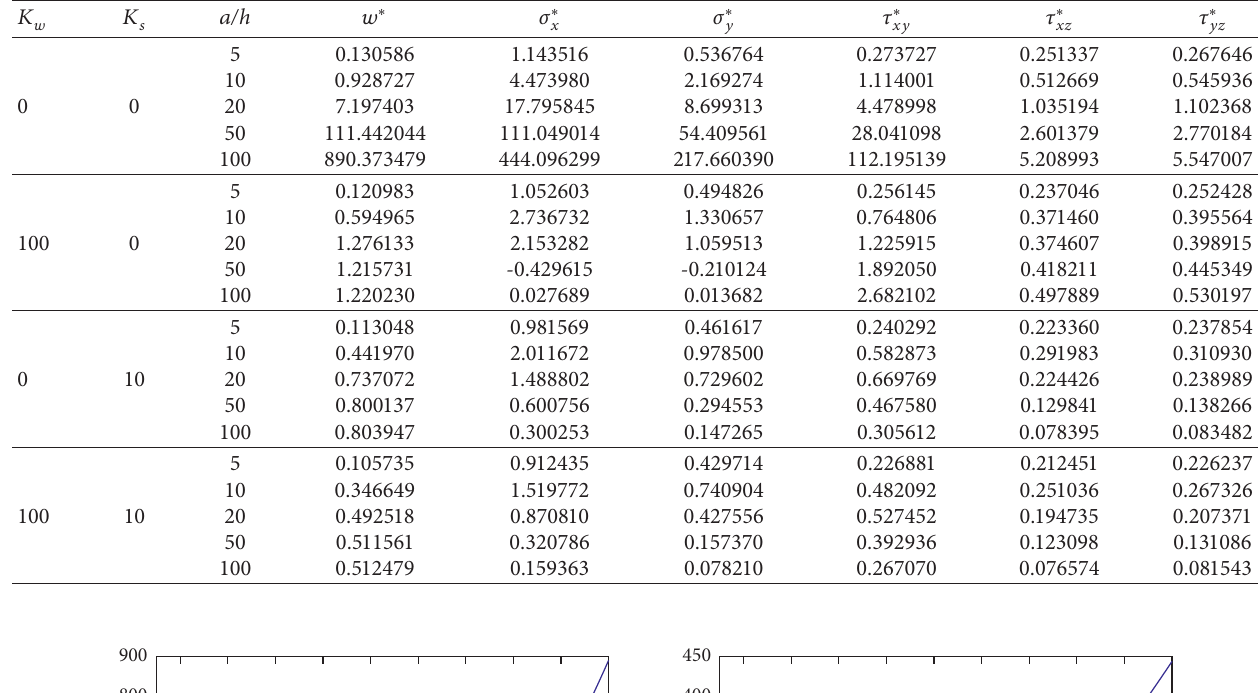
Table 5: The effects of side-to-thickness ratio on the deflection and stresses of the plates.